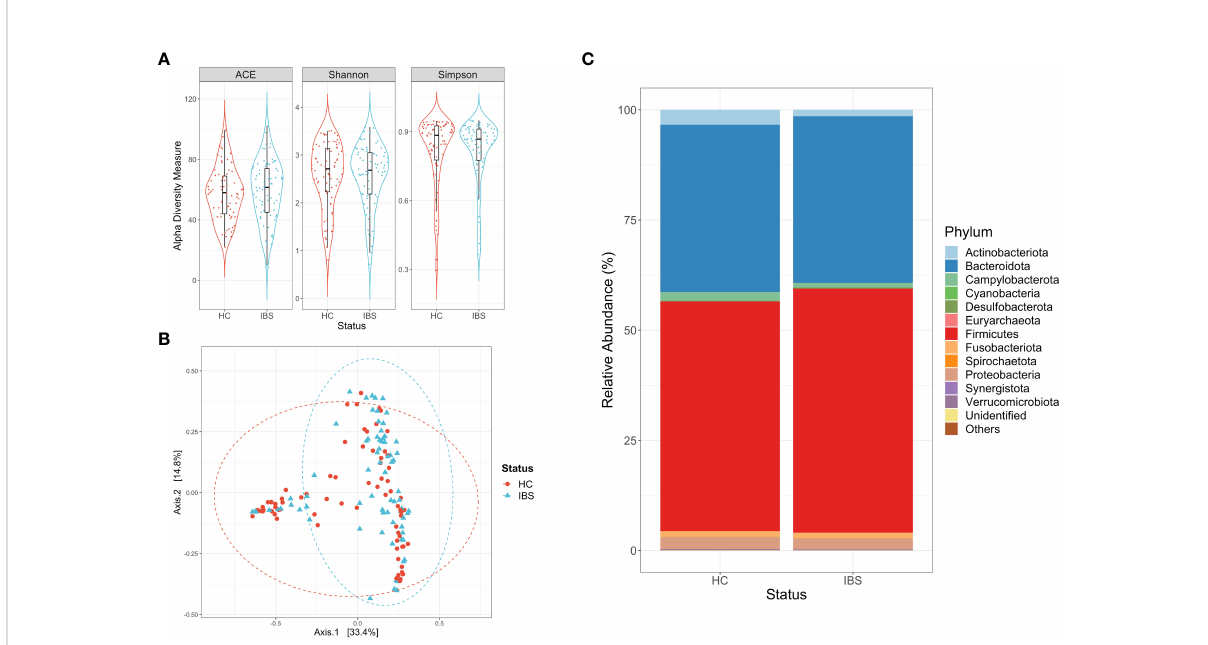
FIGURE 4 Descriptive analysis for the consolidation of studies focused on irritable colon syndrome (IBS). (A) Alpha diversity measures calculated for the ASVs of subjects with IBS and their respective controls (HC). Statistical differences were evaluated with a Mann-Whitney test (p-value >0.05). (B) Principal Coordinate Analysis (PCoA) for the ASVs of the group of subjects with the disease and their respective controls. Statistical differences of beta diversity were evaluated with the adonis test (r 2 = 0.023, p-value >0.01). (C) Relative abundance of the phyla for each of the study groups, being Firmicutes, Bacteroidota, and Actinobacteriota the predominant